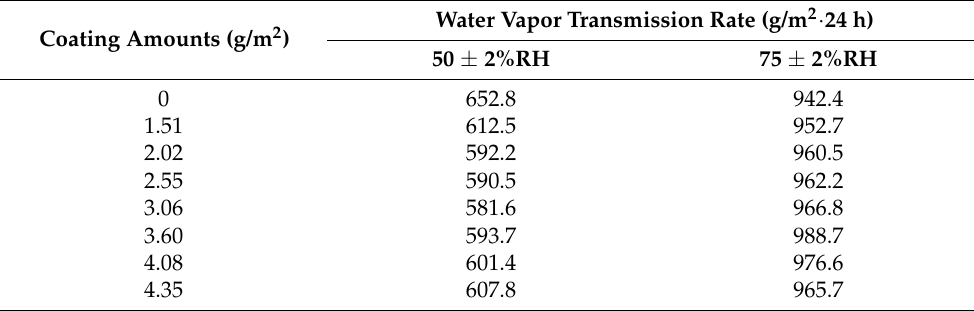
Table 7. Moisture permeability of wrapping paper with different coating